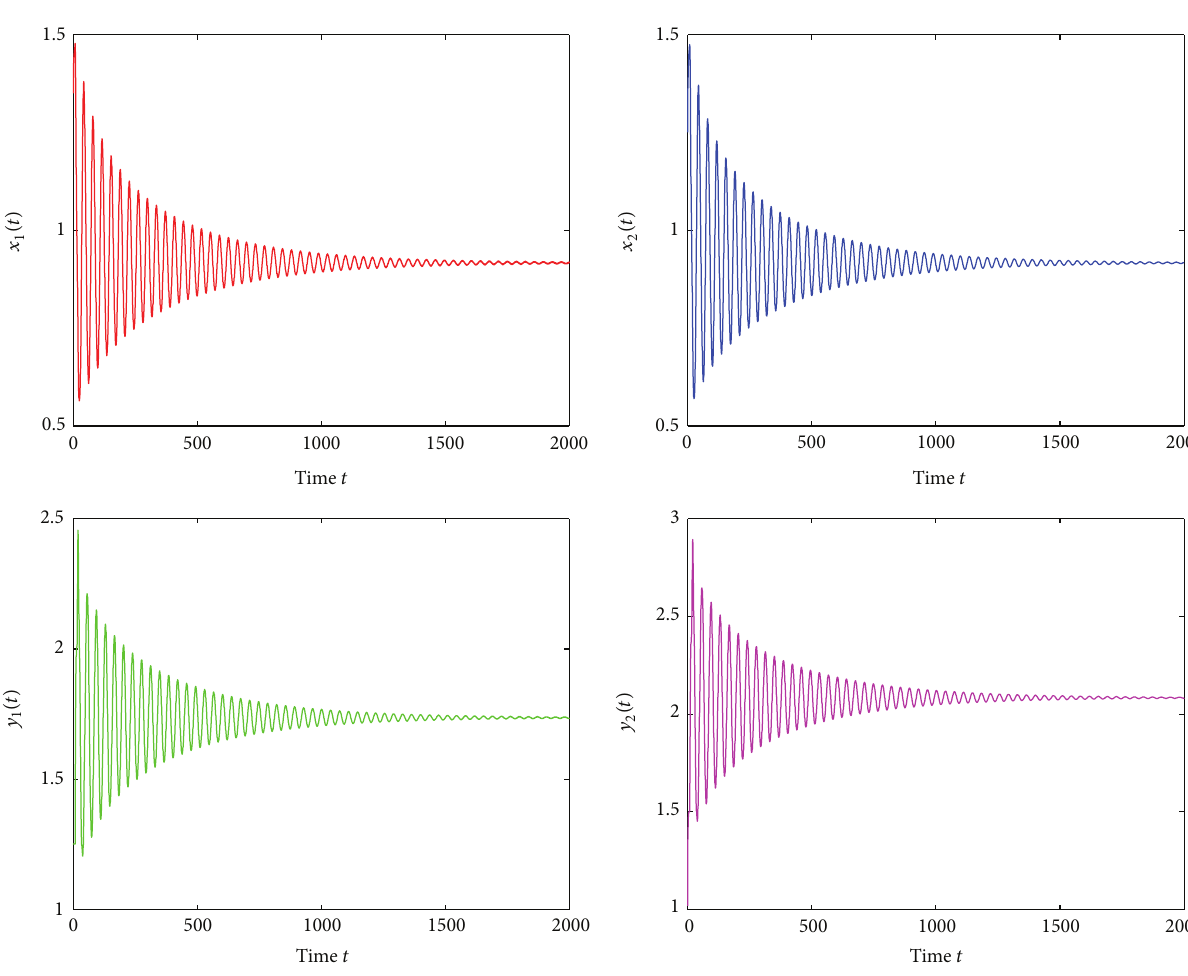
Figure 7: The track of the states 𝑥 1 , 𝑥 2 , 𝑦 1 , 𝑦 2 for 𝜏 2 = 7.7500 < 𝜏 20 = 9.9183